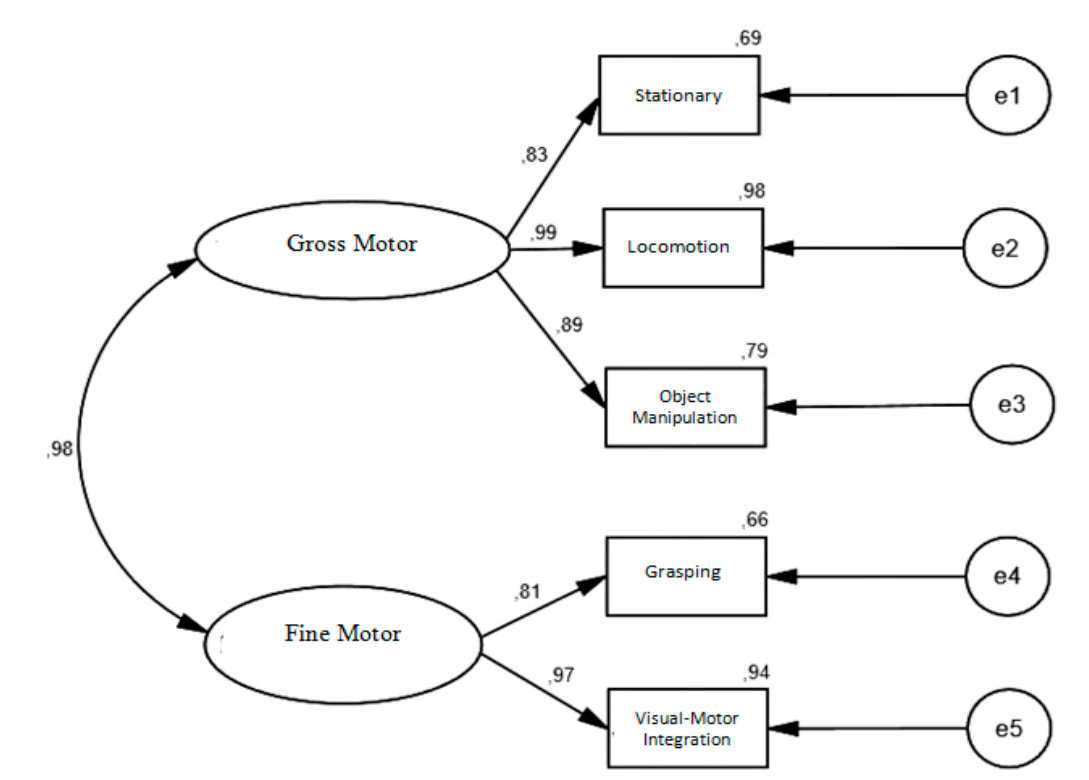
Figure 1. Factorial structure of the PDMS-2 measurement model for the Portuguese sample aged between 12 and 48 months. Table 4. Adequacy indexes of the model tested between 12 and 47